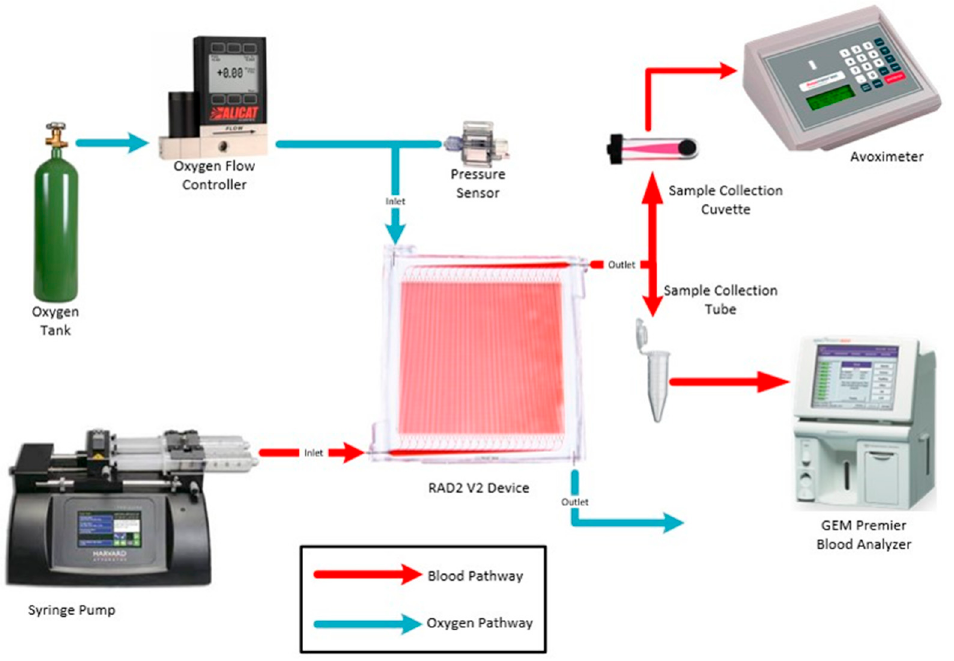
Figure 3. Schematic illustrating test circuit for blood gas transfer testing, showing various components in the test apparatus. The oxygen source bottle is on the left (pure oxygen), with the O 2 flow metered by the oxygen flow controller, and pressure measured by the sensor as shown. The RAD2v2 device is in the center, with the syringe pump delivering blood as shown on the left. Blood exits the device on the right and is measured for blood gas parameters with the hemoximeter (upper right) and blood gas analyzer (lower right), providing data including hematocrit, dissolved oxygen concentration, and hemoglobin-bound oxygen.